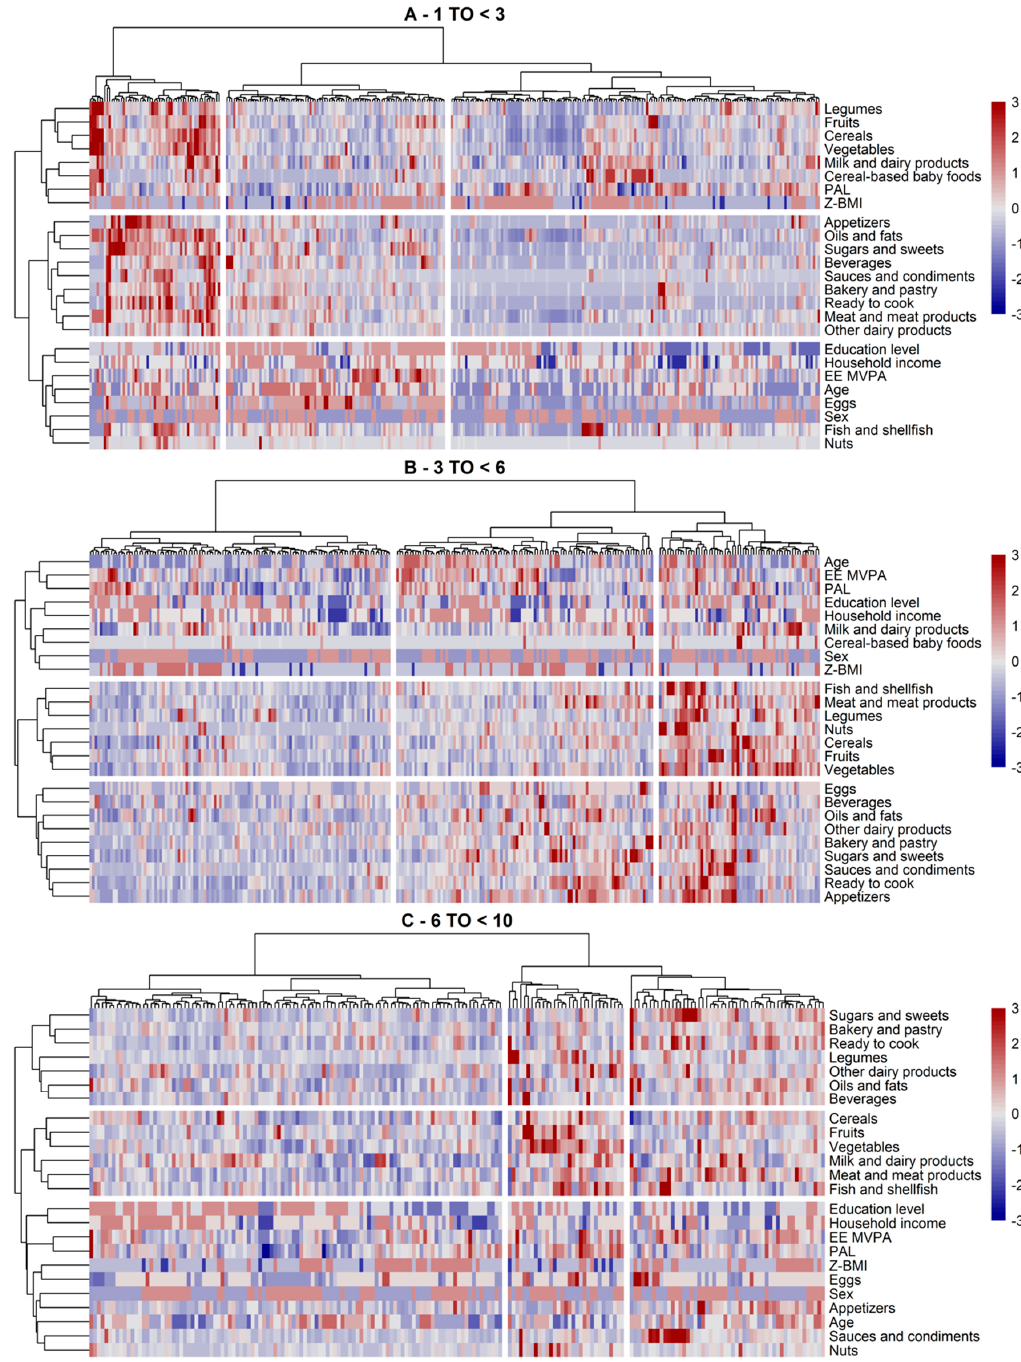
Figure 4. Clusters of subjects and dietary/lifestyle variables identified via hierarchical clustering in the AMS by age group (( A ) 1–3 years, ( B ) 3–6 years, ( C ) 6 to <10 years) in the Nutritional Study in Spanish Pediatric Population (EsNuPI) ( n = 772). The clusters are visually separated by longitudinal marks on vertical and horizontal faces (clusters of subjects or dietary/lifestyle variables, respectively). The vertical and horizontal dendrograms denote the relationship between the clusters, i.e., similar observations. The color bar refers to levels above (red) or below (blue) the mean intake of dietary variable or mean scores of lifestyle variables. Increased color intensities indicate larger differences around the mean. Abbreviations: EE MVPA, energy expenditure moderate and vigorous physical activity; PAL, physical activity level; Z-BMI-for-age, body mass index for age z-score.